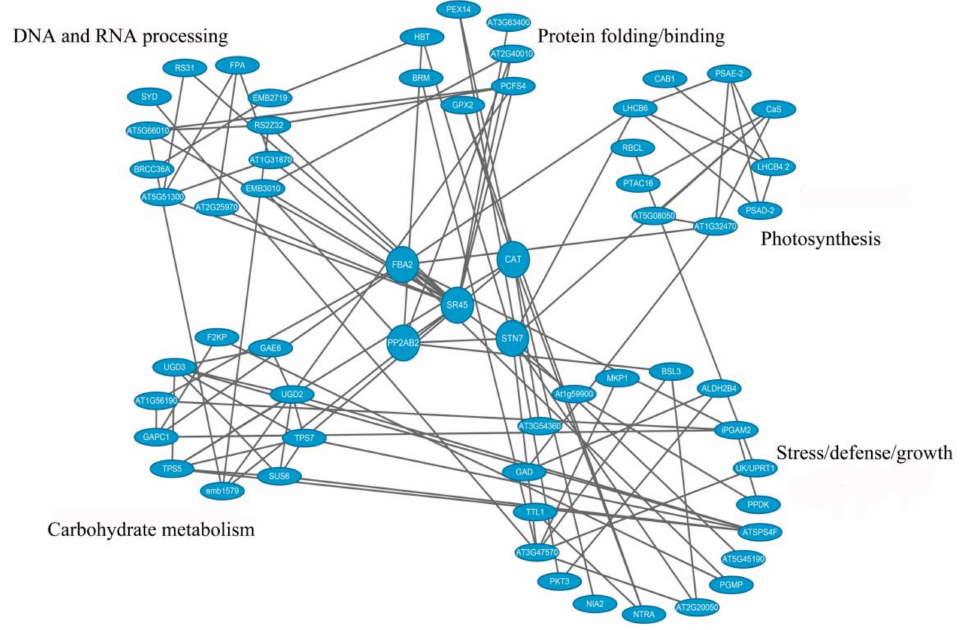
Figure 7. Protein–protein interaction networks of some important phosphoproteins in five functional